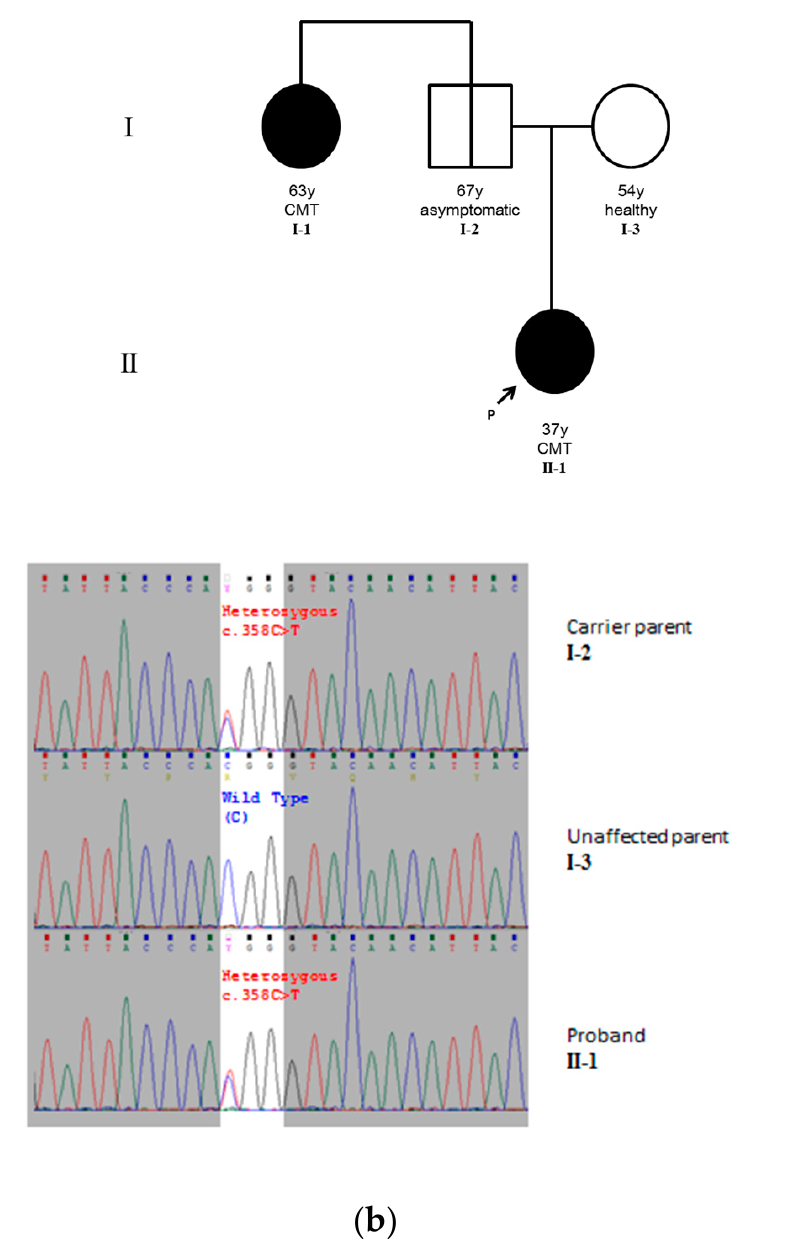
Figure 1. ( a ) Pedigree showing the autosomal recessive inheritance in Case 1 with selected electrophoretograms from Sanger sequencing in the cascade screening. Unaffected siblings II-3 to II-5 are all negative for the HSPB1 :NM_001540:c.250G>A (p.G84R) variant. Both parents (I-1 and I-2) are heterozygous for the variant, whereas the proband (II-2) and his affected elder sister (II-1) are both homozygous for the pathogenic variant; ( b ) Pedigree showing the autosomal dominant inheritance in Case 2. The proband (II-1), her father (I-2) and her paternal aunt (I-1) are all heterozygous for the pathogenic variant GDAP1 :NM_018972:c.358C>T (p.R120W), and the proband’s mother (I-3) is homozygous for the wildtype allele. The phenotype of I-2 may be explained by the incomplete penetrance of dominant GDAP1 mutations, which is discussed in text. In the figure, filled circles and squares denote affected females and males, respectively. A central dot in a symbol denotes an asymptomatic carrier and a line through the symbol denotes a currently asymptomatic carrier who may later develop the disease. The probands are marked with an arrow and a letter